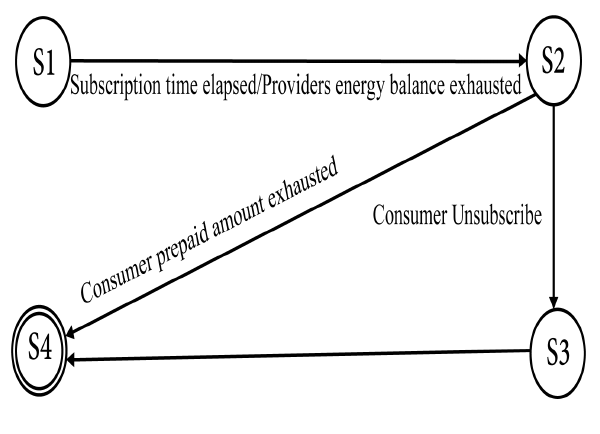
Figure 11. State diagram.